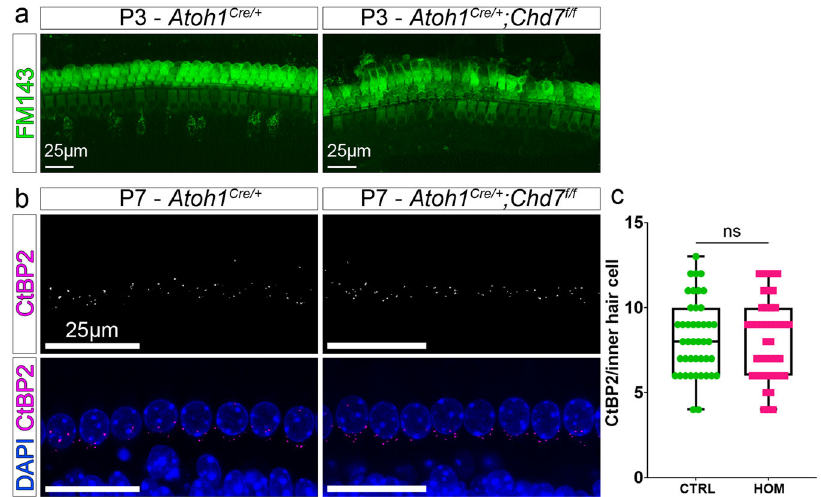
Fig. 2 Hair cell development is not affected by Chd7 deletion. a Cochlear explants of control and Chd7 homozygous mutants were treated with FM1-43 for 30 s to assess mechanotransduction. b CtBP2 immunohistochemistry of control and Chd7 homozygous mutants at P7 shows that ribbon synapses at the inner hair cells are unaffected in mutants. c Quanti fi cation of CtBP2 puncta (ribbon synapses) per inner hair cell. CTRL = control; HOM =